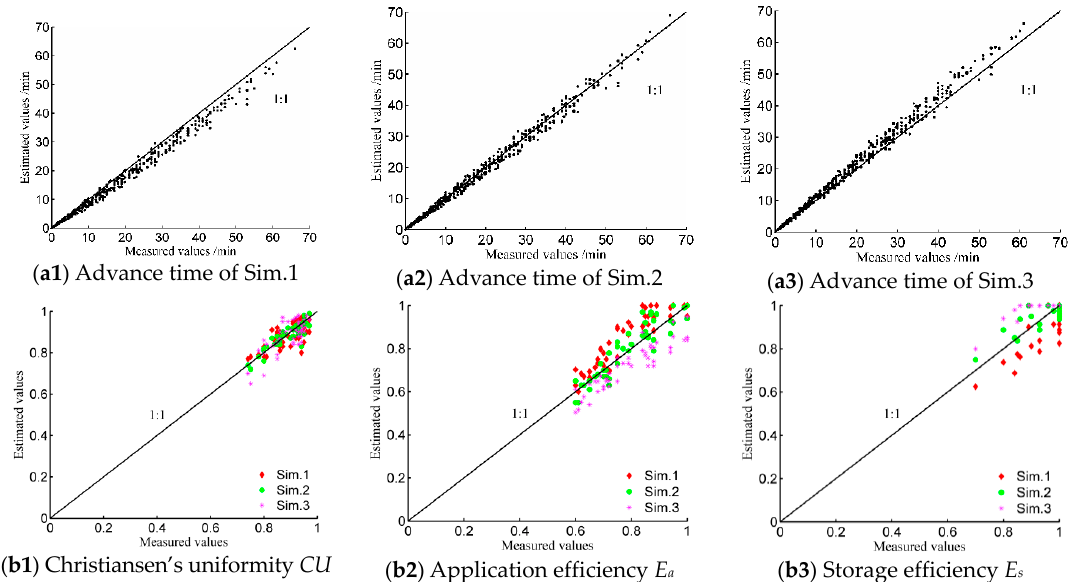
Figure 4. Comparisons of measured and simulated advance time and irrigation performance indicators in WinSRFR under the three scenarios. Notes: Sim.1: Manning’s roughness cumulative frequency = 5%; Sim.2: Manning’s roughness cumulative frequency = 50%; Sim.3: Manning’s roughness cumulative frequency = 95%.